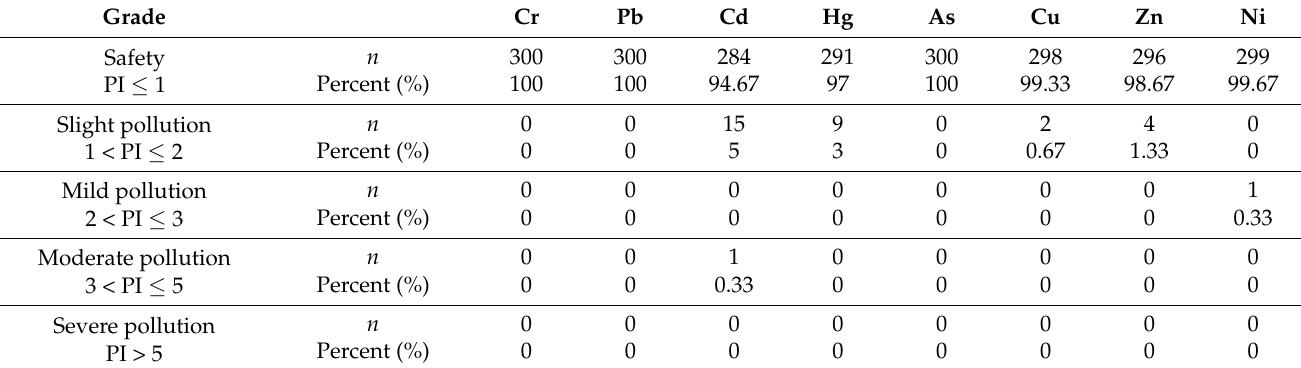
Table 4. Pollution status assessed by pollution index ( n =